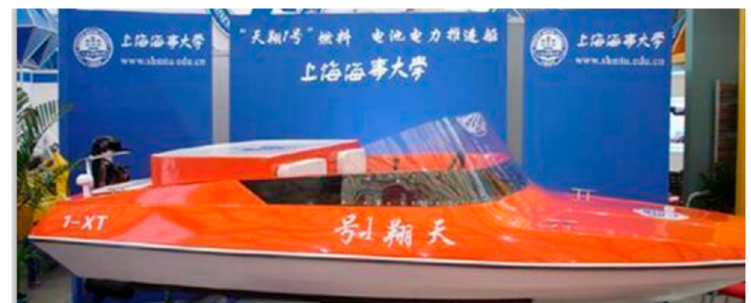
Figure 29. The yacht “Tian Xiang 1” [151].